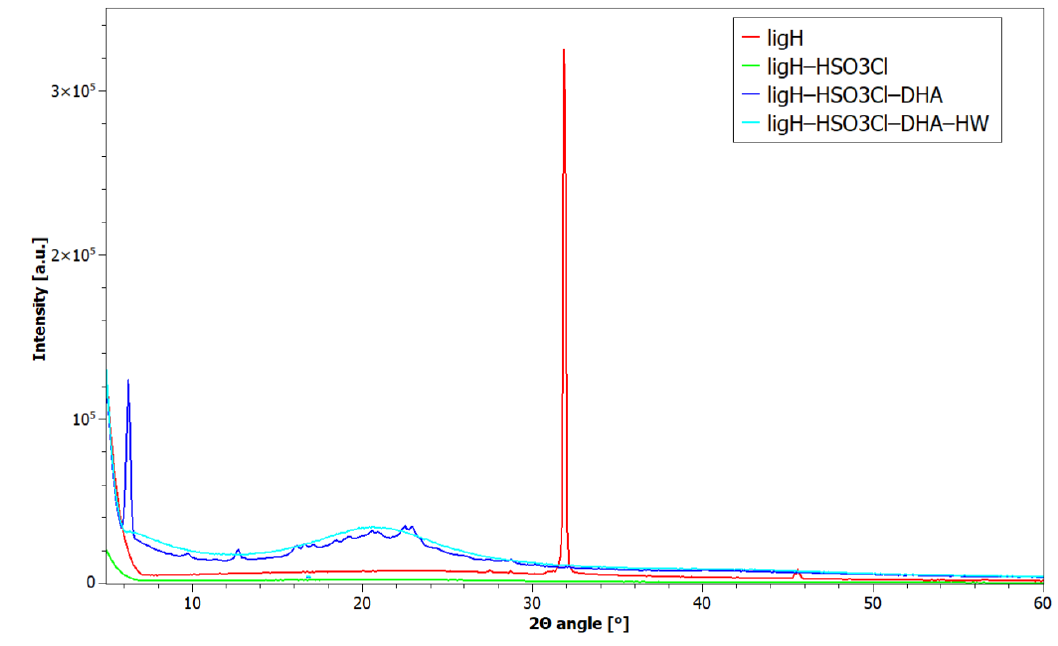
Figure 4. Solid-State 13 C NMR spectrum of the ligH-HSO 3 Cl-DHA-HW sample.